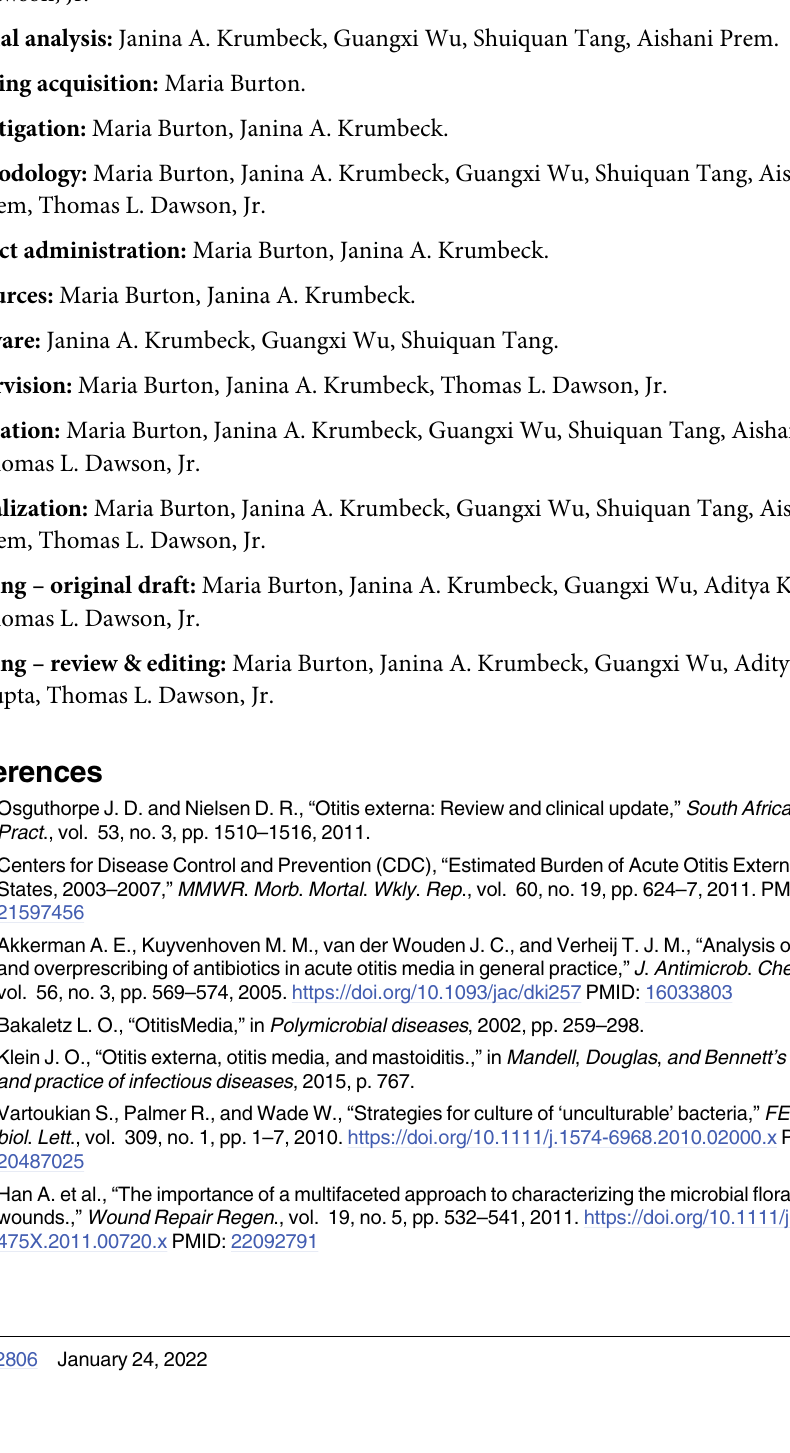
S1 Table. Relative abundance table for bacterial profile per sample. S2 Table. Relative abundance table for fungal profile per